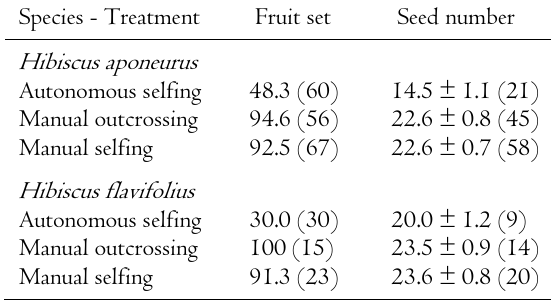
T ABLE 3. Fruit set (percentage of total flowers pollinated that developed a fruit) and mean ± S.E. number of seeds/fruit for three pollination treatments from H. aponeurus and H. flavifolius, performed in the greenhouse at Indiana University South Bend. fruit set) and numbers of fruits sampled (for seed